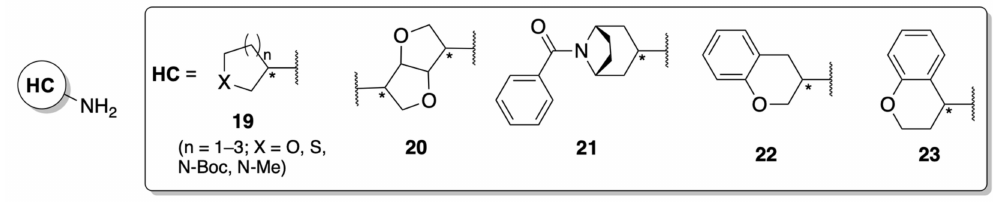
Figure 4. Amines from biocatalytic transamination of the corresponding cyclic ketones.